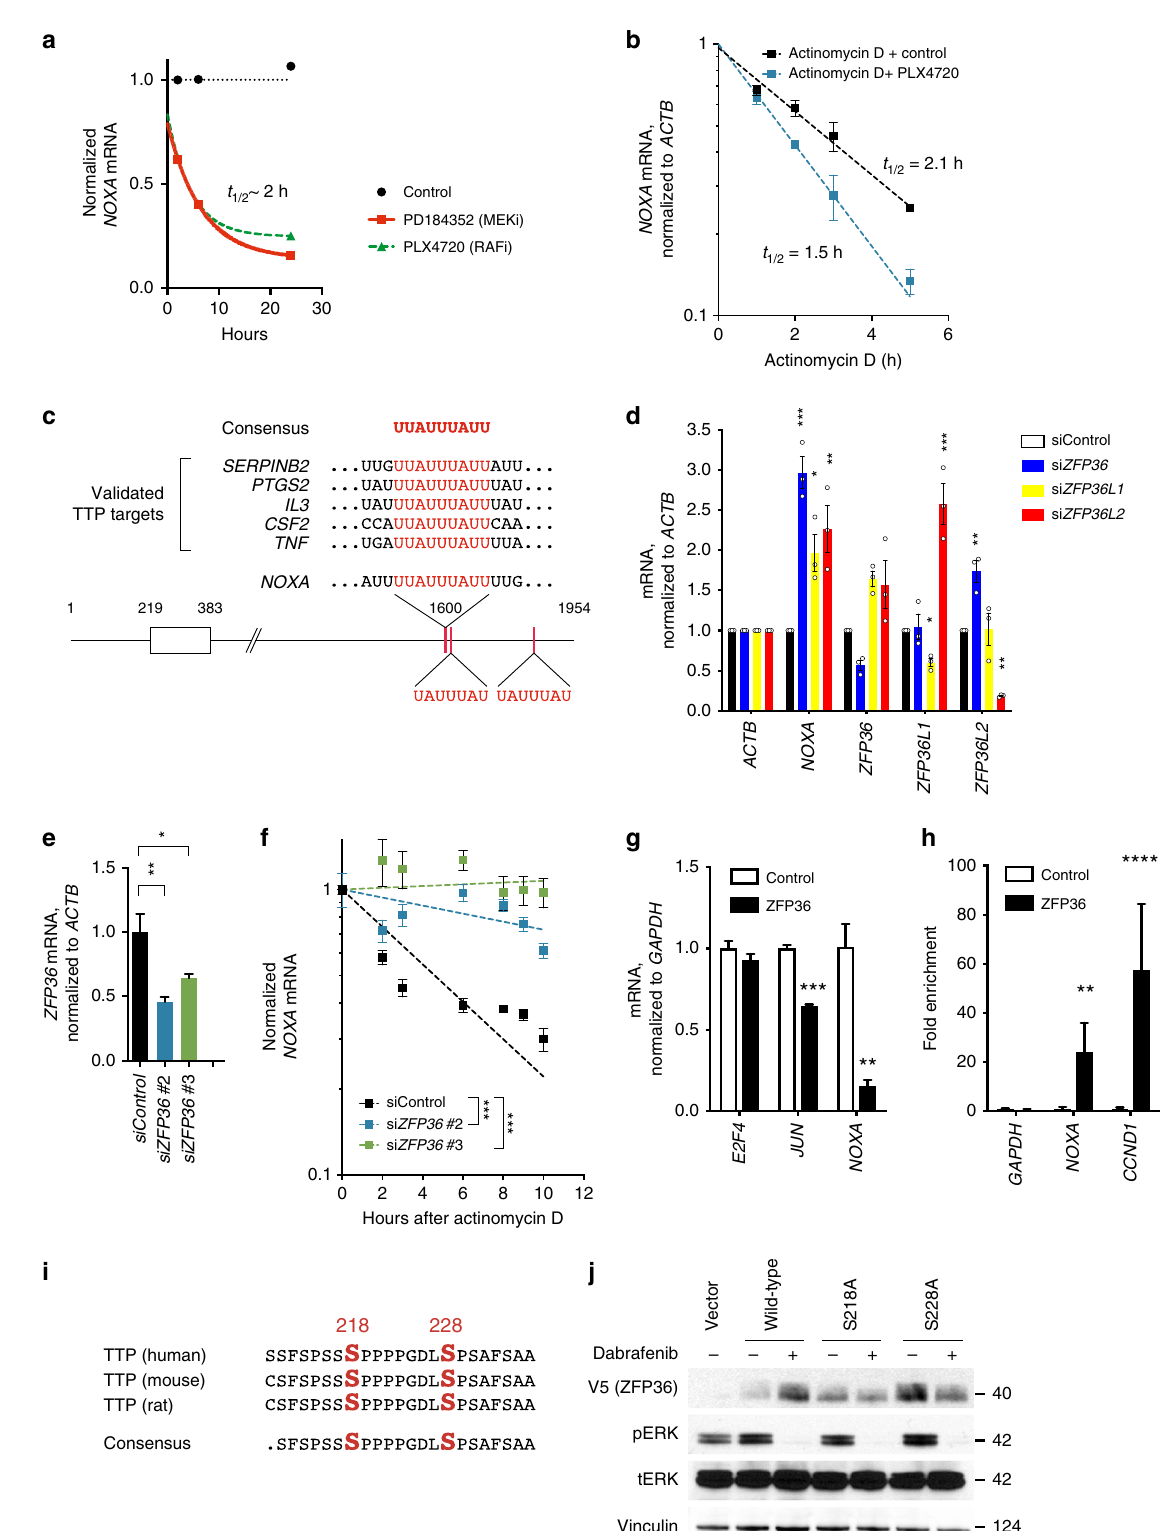
obtained RNA from three melanoma patients with BRAF -mutant melanomas before, and 14 days after starting single agent vemurafenib. In each case, on-treatment NOXA and DUSP4 (a measure of MAPK activity) mRNA were suppressed compared